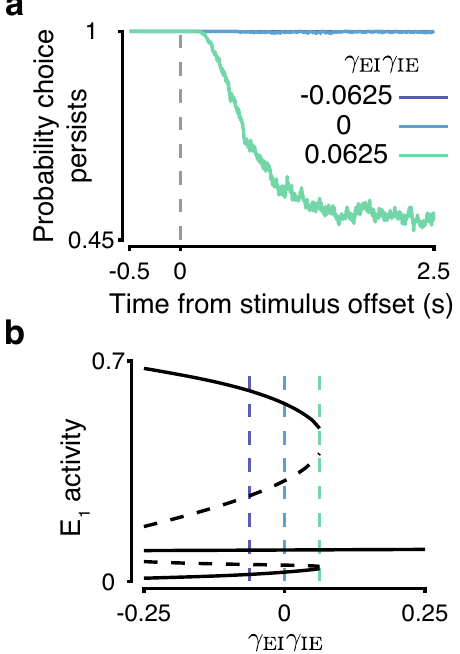
Fig. 4 | Strong ipsispeci fi c inhibition destabilizes working memory attractors. a The probability of maintaining a choice after stimulus offset is diminished in ipsispeci fi c circuits. b For ipsispeci fi c circuits with high γ EI γ IE , working memory attractors are extinguished after merging with saddle points. The bifurcation dia- gram is for the same circuits as in Fig. 3g but in the absence of